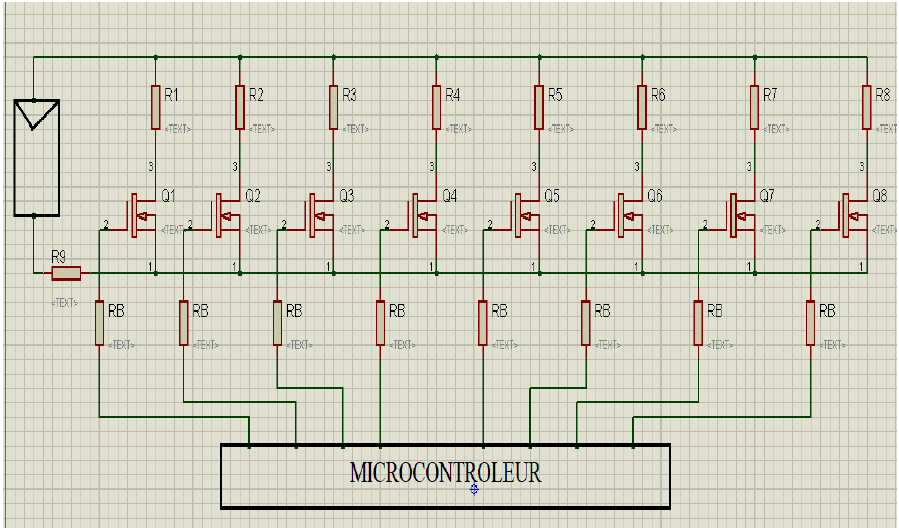
Figure 4: Circuit of the electronic